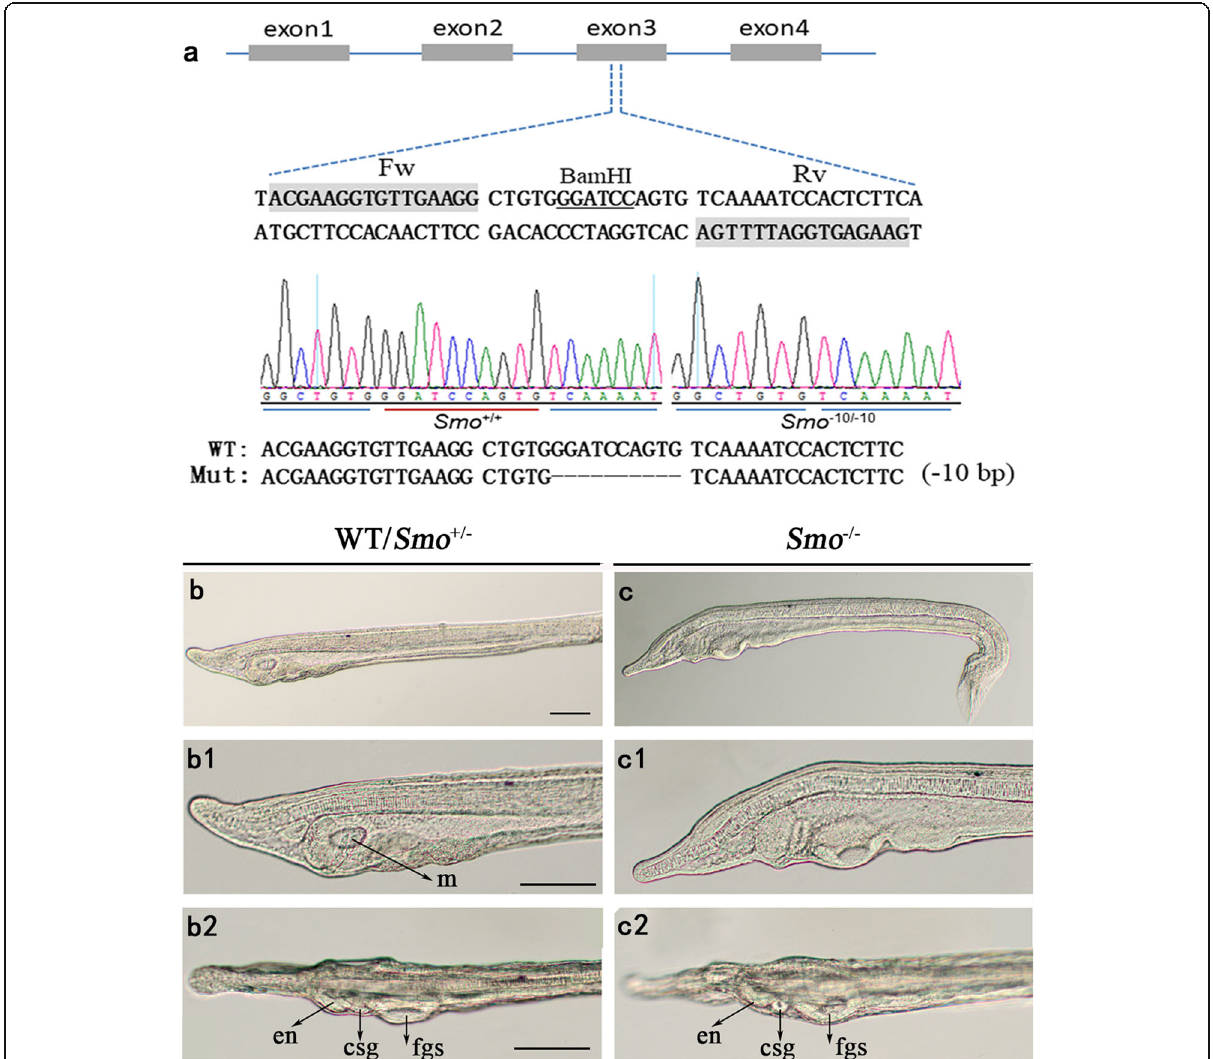
Fig. 2 Hh signaling is necessary for mouth opening in the amphioxus. a: Information on the Smo TALEN target site and the sequencing results of wild-type and Smo mutant embryos. Binding sites for the TALEN pairs [forward (Fw) and reverse (Rv)] used in this study are highlighted in gray. The BamH I site in the spacer is underlined. b: phenotypes of wild-type and Smo +/ − embryos. c: phenotypes of Smo mutant embryos. The mouth present in wild-type and Smo +/ − heterozygotes is lost in Smo − / − homozygous mutants, while the other pharyngeal organs, including the endostyle, club-shaped gland and first gill slit, are unaffected, m, mouth; en, endostyle; csg, club-shaped gland; fgs, first gill slit; scale bar 100 μ